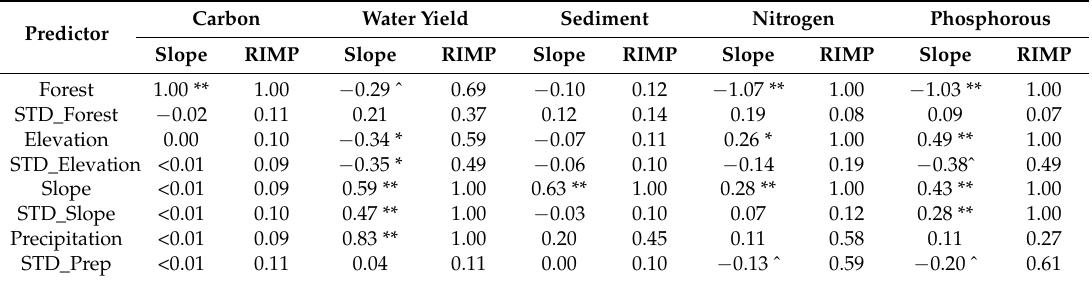
Figure 4. Spatial distribution of modeled ( a ) carbon storage (mg per ha), ( b ) water yield (mm), ( c ) sediment export (kg per ha), ( d ) nitrogen export (kg per ha), and ( e ) phosphorus export (kg per ha) across the NFKR Watershed under the FRA scenario. Table 5. Slope coefficient (Slope) and relative importance (RIMP) of the predictor variables estimated from a model average approach for explaining variability of the five biophysical indicators of ecosystem services at the subwatershed level.